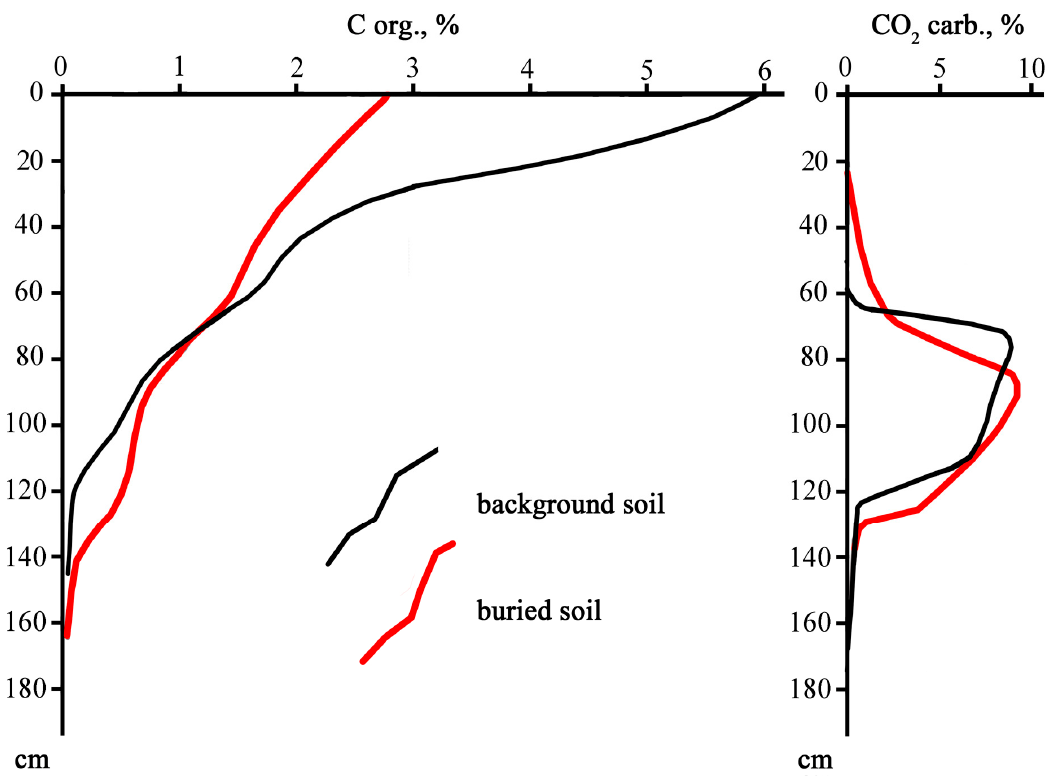
Figure 5. Profile distribution of C org and CO 2 of carbonates in the Chernozem buried under the Bronze Age burial mound (red line) and in the modern Chernozems (black line).